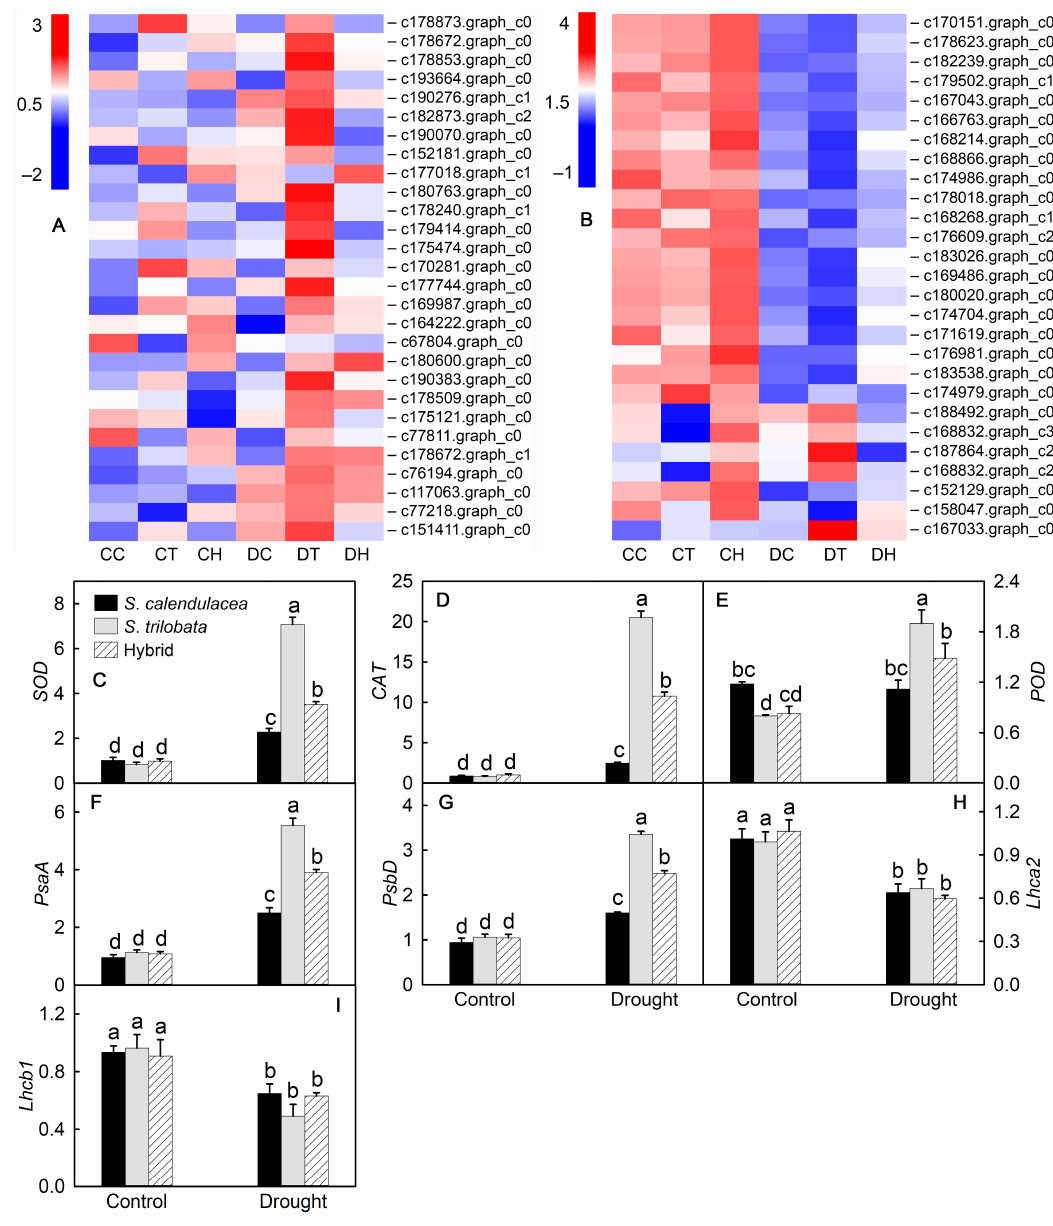
Figure 6. Heatmap of gene expression and results of real-time PCR validation. Heatmap of genes related to antioxidant enzymes synthesis ( A ) and photosynthetic pathway ( B ), and the results of real-time PCR validation ( C – I ) under normal irrigation (control) and drought treatment (drought) in leaves of S . calendulacea , S . trilobata and their hybrid. Different lowercase letters (a, b, c, d) above bars indicate statistical significance ( p < 0.05). CC: control of S. calendulacea ; CT: control of S. trilobata ; CH: control of the hybrids; DC: drought stress treatment of S. calendulacea ; DT: drought stress treatment of S. trilobata ; DH: drought stress treatment of the hybrids.